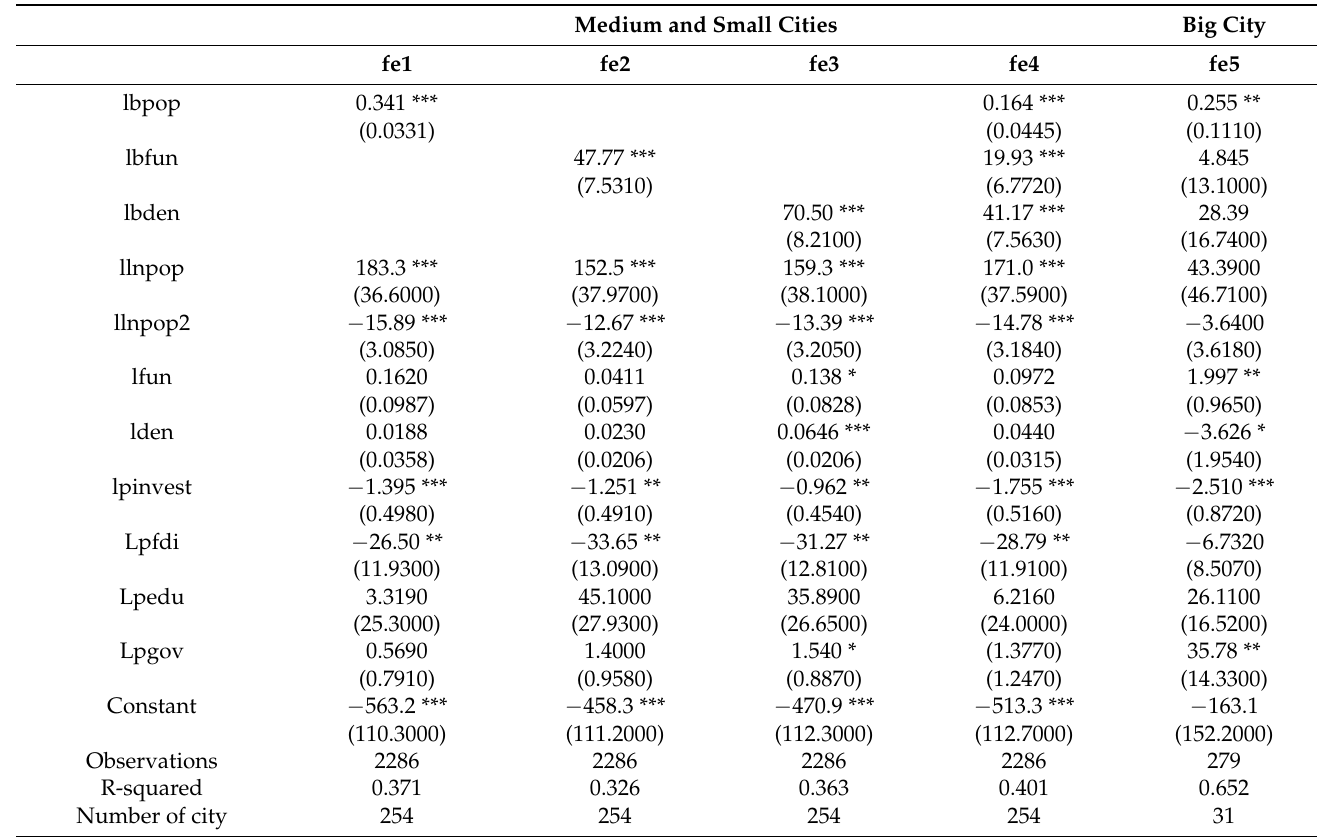
Table 1. Results of regression analysis using the fixed-effects model. Medium and Small